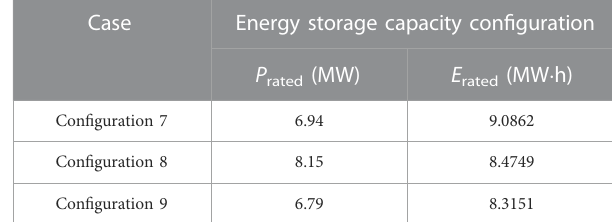
TABLE 8 Energy storage capacity con fi guration considering